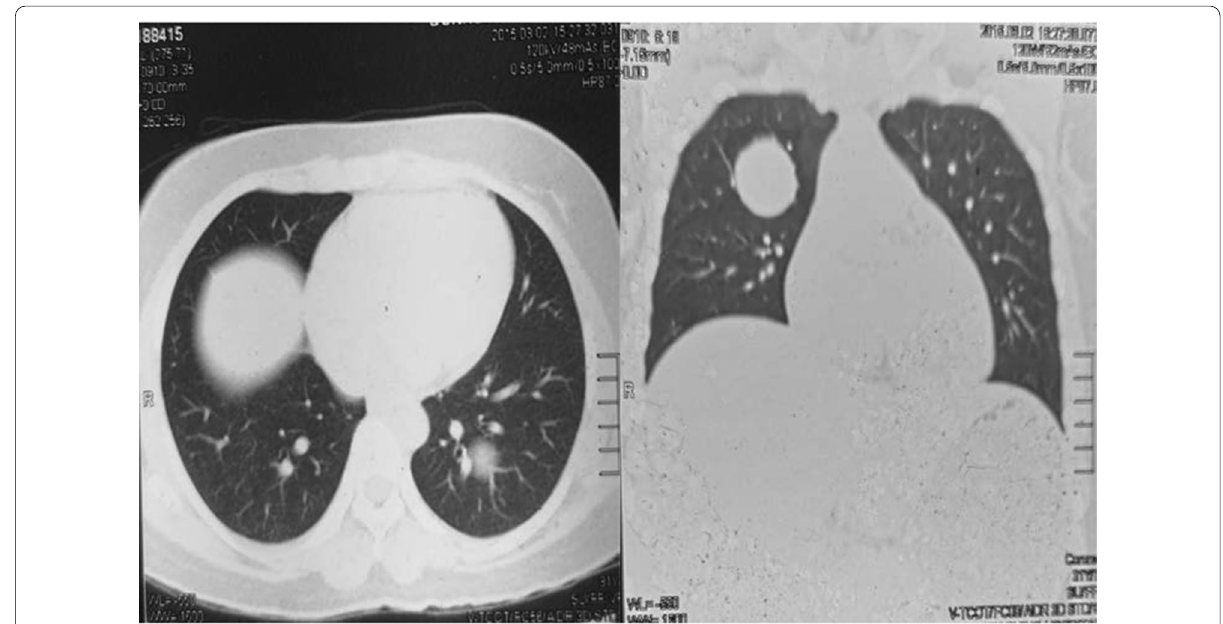
Fig. 2 Preoperative contrast‑enhancing CT images of the chest showing multiple well‑defined enhancing lesions in both lung